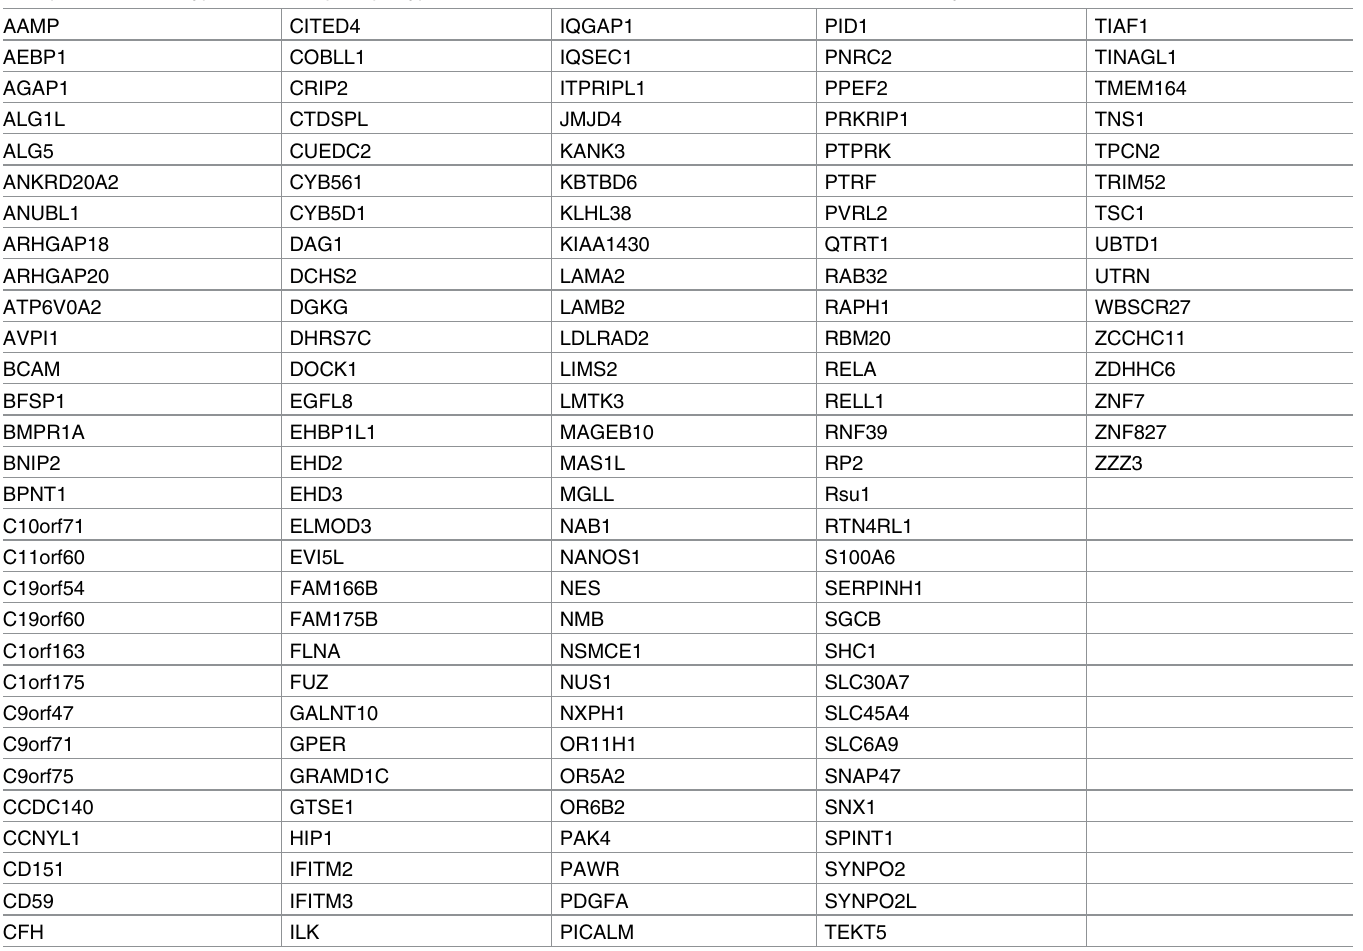
Table 2. Proteins curated from the Human Protein Atlas that are expressedin both EC and VSMC of the brain. All proteins (n = 135) are predicted to be expressedin both types of the two principle types of vascular cells but not other cells of the central nervoussystem.